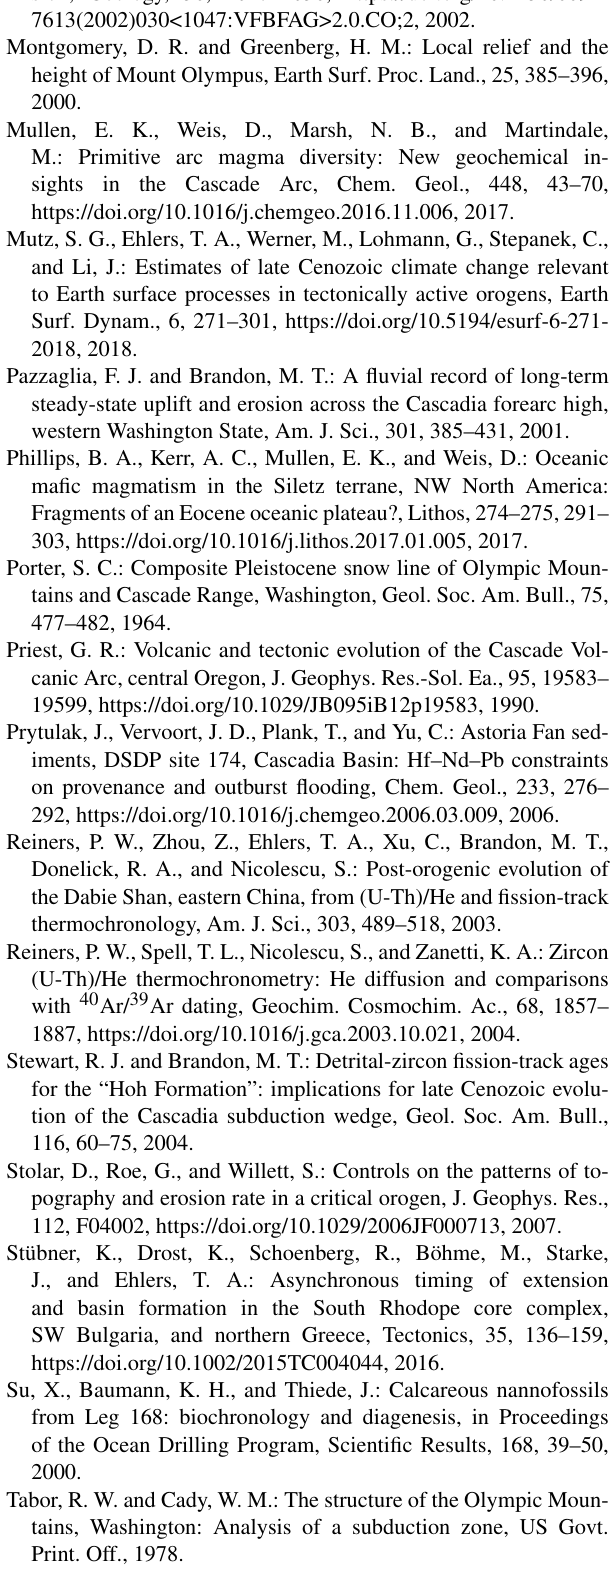
Tabor, R. W. and Cady, W. M.: The structure of the Olympic Moun- tains, Washington: Analysis of a subduction zone, US Govt. Print. Off.,